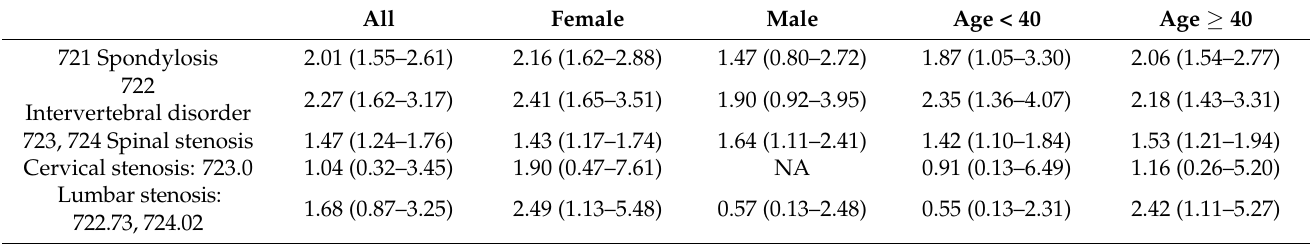
Figure A1. Flowchart of the study selection process. Table A1. Sub-outcome Cox proportional hazard model analysis for risk of spinal degeneration (HV vs. non-HV).